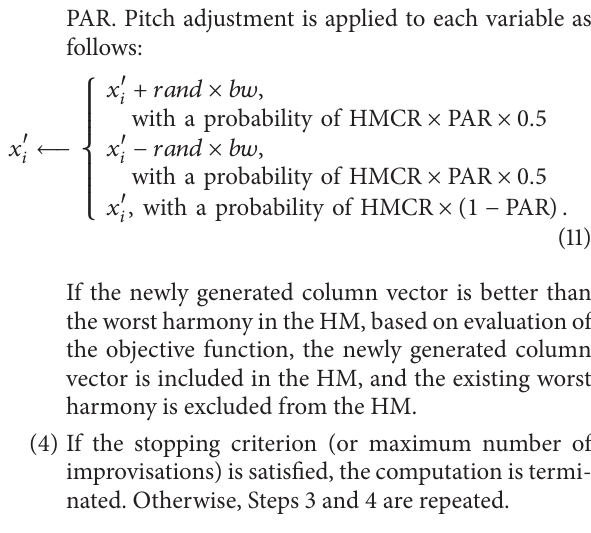
Figure 2: Minimizing the error function of (8) through the HS algorithm.